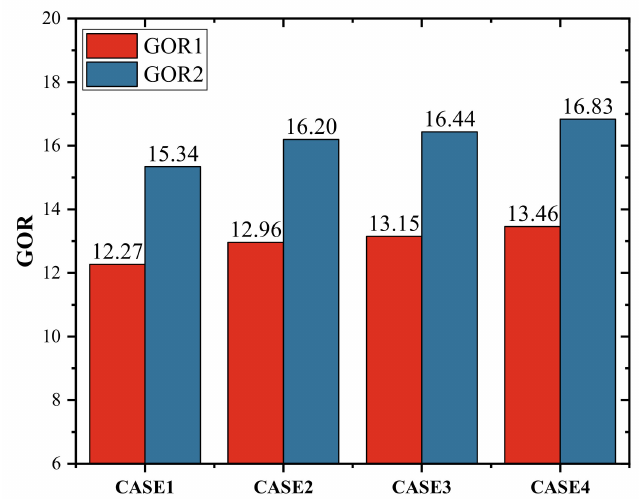
Figure 12. GOR1 and GOR2 under different arrangements of